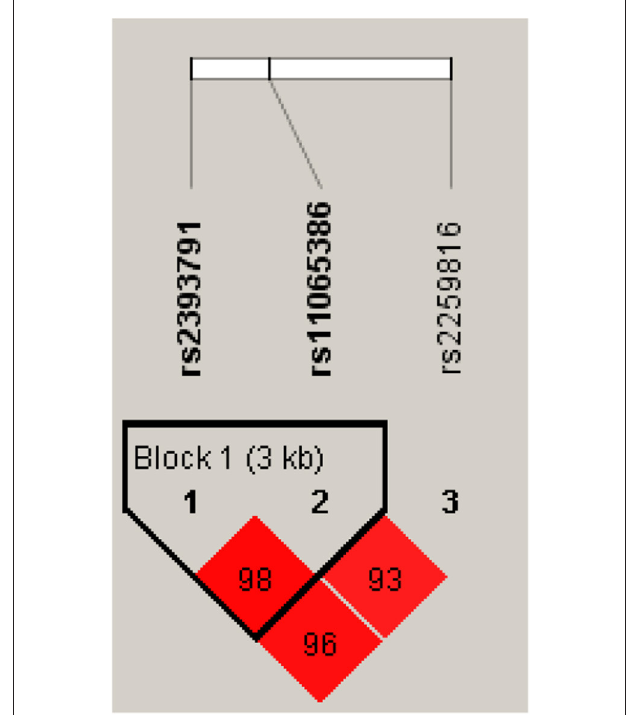
FIGURE 1 | Linkage disequilibrium block of HNF1A